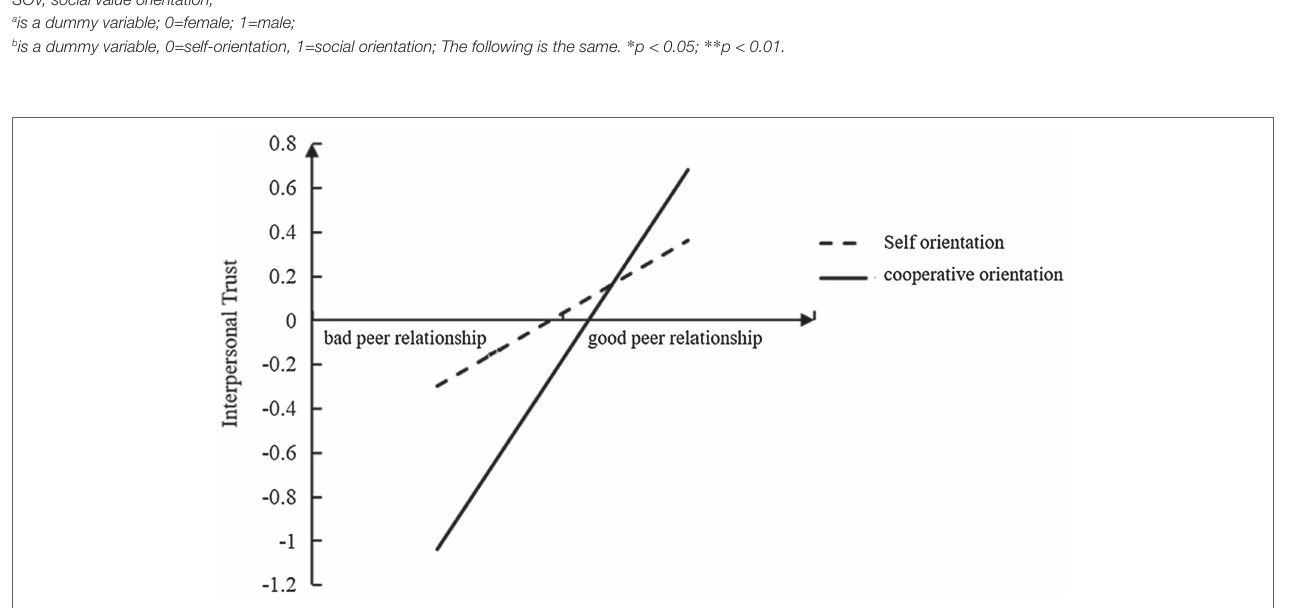
Figure 3 . The results showed good model fit ( χ 2 /df = 3.84, CFI = 0.94, NFI = 0.93, GFI = 0.92, and RMSEA = 0.05). Peer relationships significantly positively predicted cooperative tendencies ( γ = 0.25, p < 0.001). Additionally, peer relationships significantly positively predicted interpersonal trust ( γ = 0.37, p < 0.001), and interpersonal trust significantly positively predicted cooperative tendencies ( γ = 0.11, p < 0.05). The interaction between social value orientation and peer relationships significantly positively influenced interpersonal trust ( γ = 0.18, p < 0.001); however, the interaction between social value orientation and interpersonal trust did not significantly influence cooperative tendencies ( γ = 0.01, p = 0.652). This suggested that interpersonal trust has a partially mediating role in the process by which peer relationships influence cooperative tendencies, and that the moderating role of social value orientation occurs only in the first half of the path, with the moderating mediation model established.